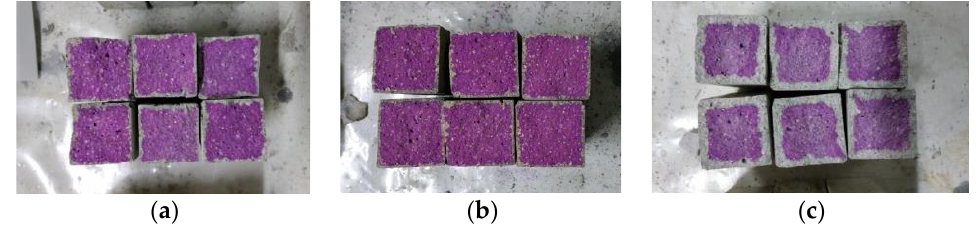
Figure 8. M1 mixture ( a ), M2 mixture ( b ) and M3 mixture ( c ) after being sprayed with phenolphtha- lein.